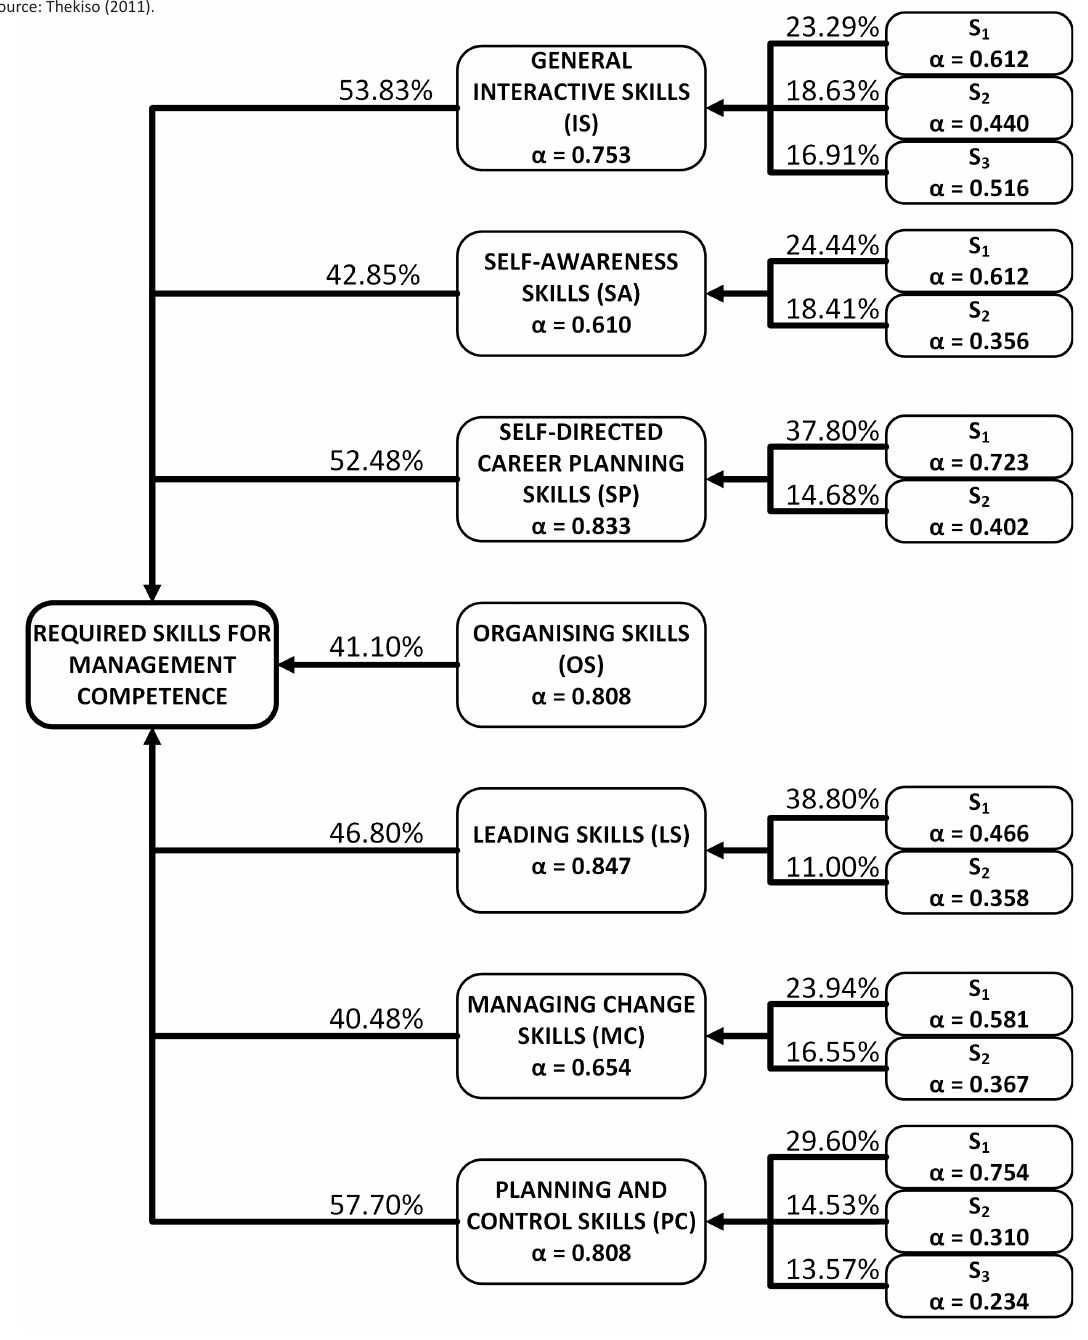
Figure 1. A model to measure skills for managerial